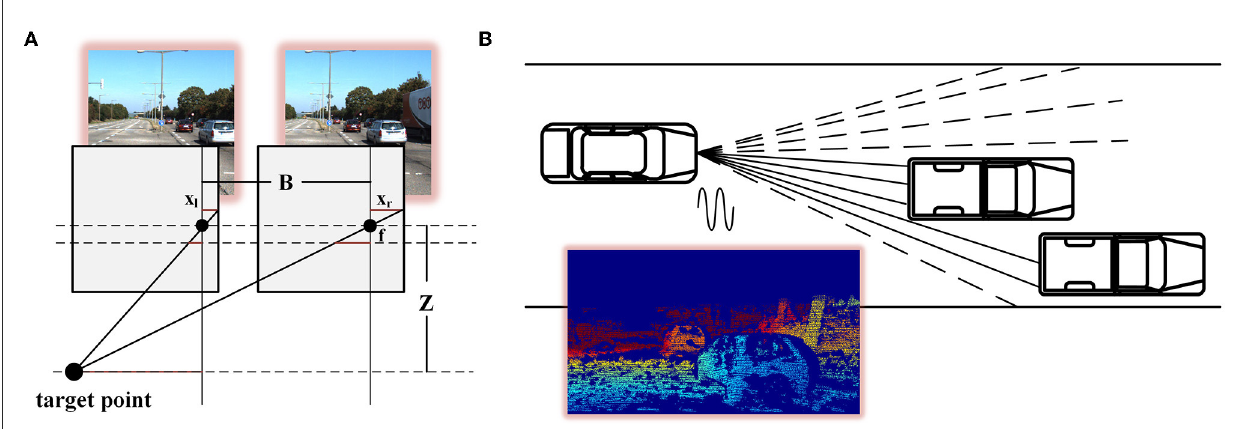
FIGURE2 Depth measurement model of stereo matching and point cloud scanning. (A) is the model of a binocular camera, the lower dot is the target point, and the upper two dots are the two cameras (B)